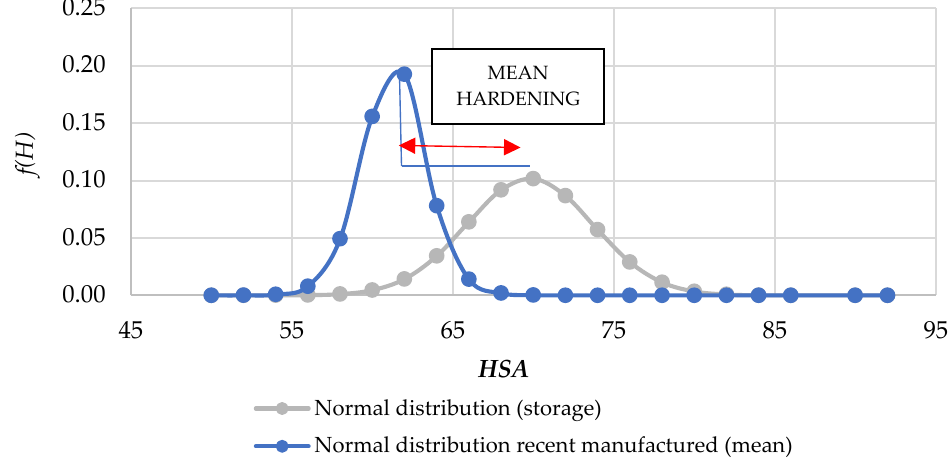
Figure 7. Hardening: difference between recently manufactured and storage normal distributions.